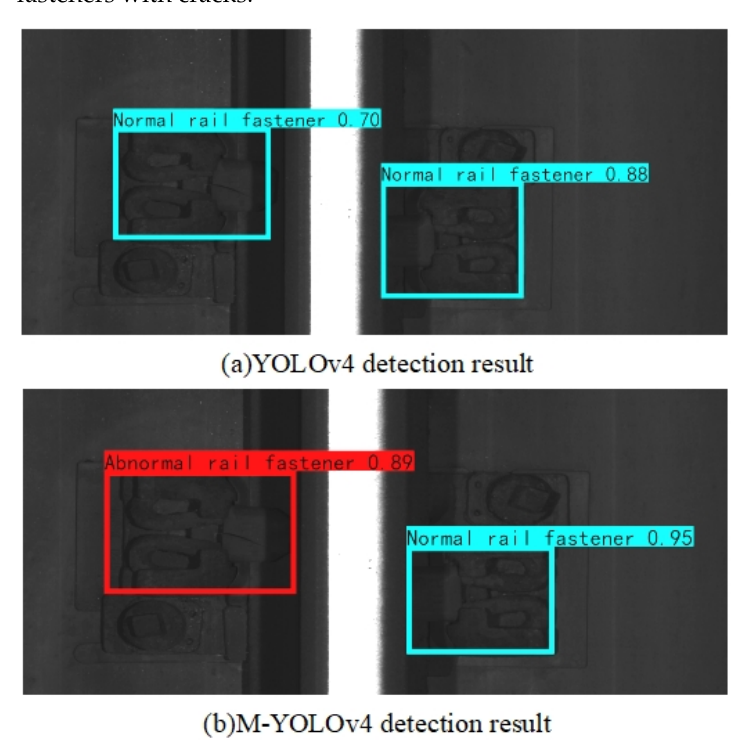
Figure 6. Detection results of rail fasteners with cracks. To show the validity of the method, the labels of 10 normal rail fastener images and 10 abnormal rail fastener images were flipped and fed into training along with the training set. The rest of the settings were not changed in the training. The model was tested using the same test set. The comparison of results after adding noise are shown in Table 2. It can be seen from Table 2 that the false-alarm rate of Faster R-CNN increased to 5.24 and the error rate increased to 3.94 after adding noise, and the detection results became worse due to the noise. The addition of noise increased the M-YOLOv4 algorithm’s false-alarm rate slightly to 6.22%, the missed-alarm rate was 0.83%, and the error rate was 3.31%. The overall performance of the algorithm remained basically unchanged, the slight fluctua- tions were caused by internal parameters, and the detection results were still good. There- fore, the algorithm proposed in this paper has certain anti-noise ability and good robust- ness. Table 2. Comparison of results after adding noise. N N D